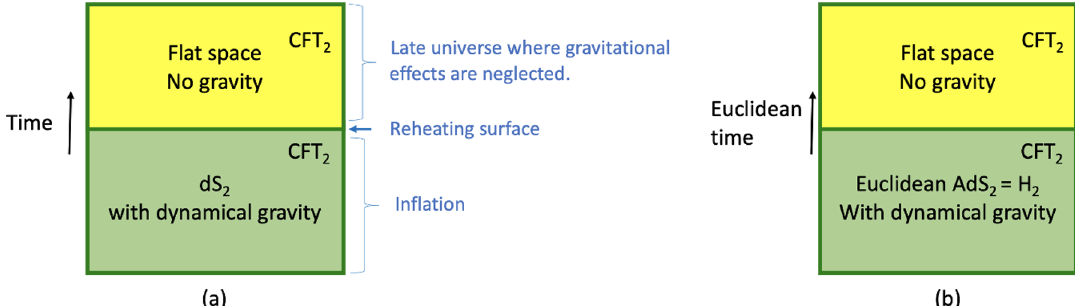
Figure 1 . The two main cases we study. (a) We model an inflationary spacetime as follows. We consider a two dimensional de Sitter JT gravity theory coupled to a matter CFT 2 . Inflation ends when the dilaton reaches a large value. We then transition to a flat space region, where we neglect the effects of gravity. This procedure produces a certain quantum state for the CFT 2 in the flat space region. (b) Another way to produce a state in a flat space CFT. We do Euclidean evolution in Euclidean AdS 2 JT gravity followed by Euclidean evolution in flat space. We impose transparent boundary conditions for the CFT 2 at the AdS 2